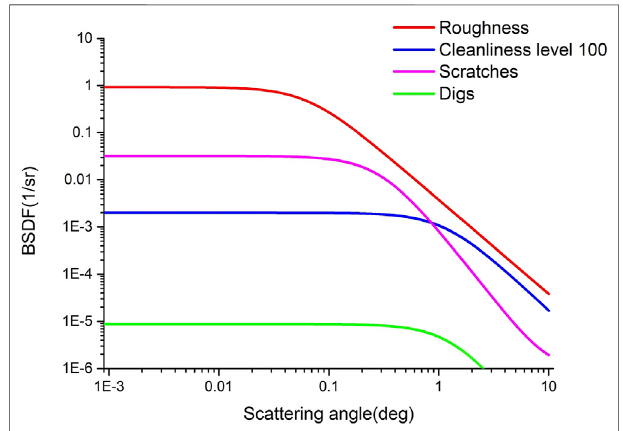
FIGURE 12 | BSDF curves as a function of the scattering angle for SCI M1 at 700.0 nm.